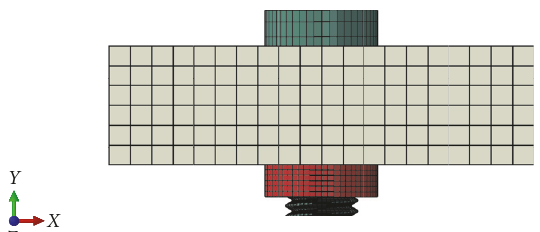
A nominal friction coefficient 0.1 is initially used for all sliding surfaces. Considering the geometric nonlinearity, the implicit dynamics module in ABAQUS is used to simulate the tightening and self-loosening